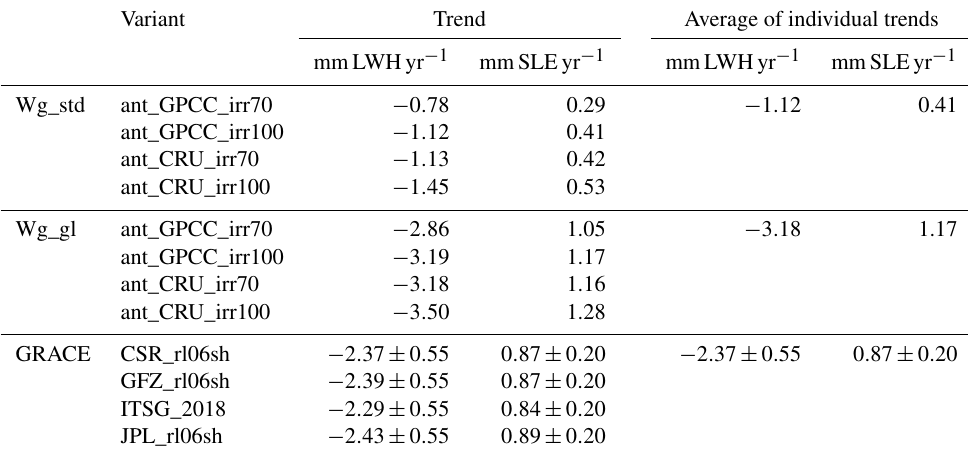
Variant Trend Average of individual trends mmLWHyr −